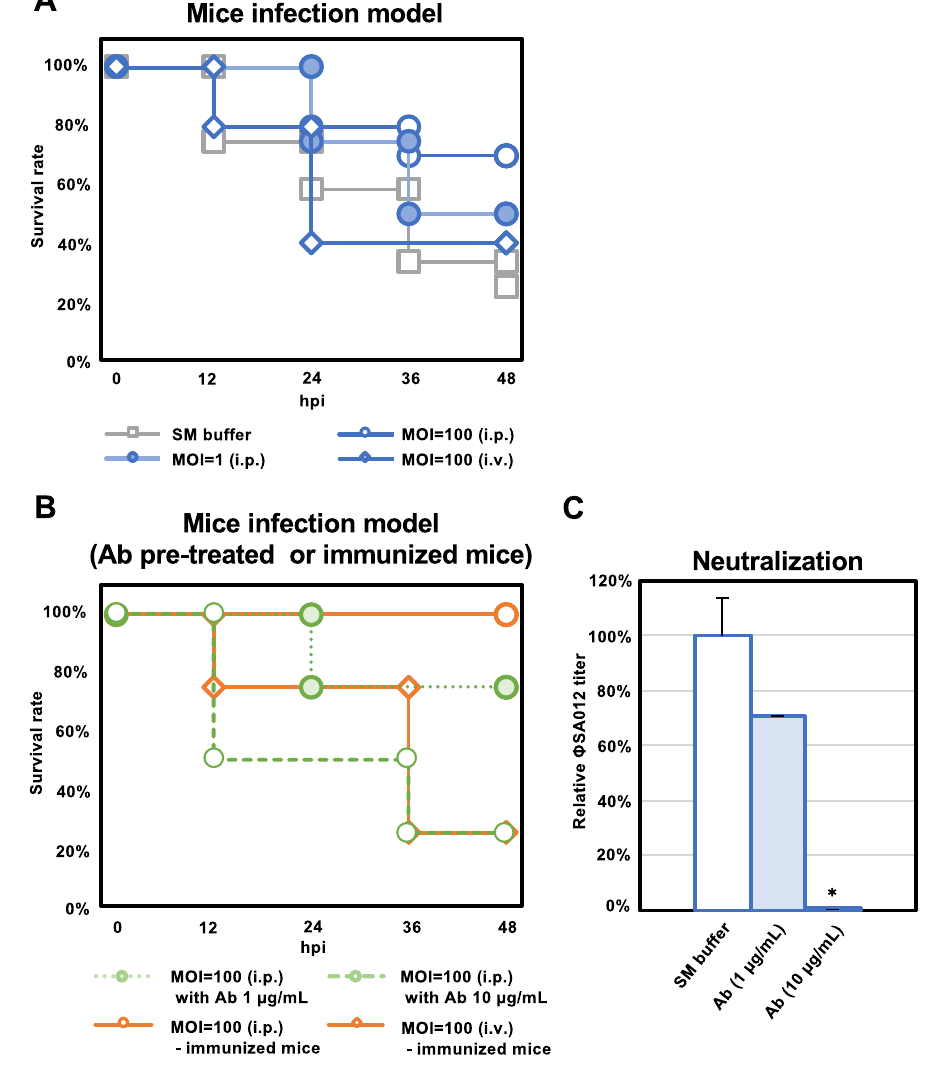
Figure 6. Therapeutic effect of ΦSA012 in a mouse infection model. ( A ) Survival rates of mice inoculated with SA003 through i.p. injections without ΦSA012 treatment (i.p. or i.v.). ΦSA012 was inoculated to mice i.p. or i.v. (n = 12 in the control group, n = 10 at MOI of 100 in the i.p. group, n = 10 at MOI of 100 in the i.v. group, n = 4 at MOI of 1 in the i.p. group). In every experiment, ΦSA012 or SM buffer was injected into mice 15 min after SA003 inoculation. ( B ) Survival rates of mice inoculated with SA003 through i.p. injection with anti-phage antibody (1 µg/mL or 10 µg/mL)-pretreated ΦSA012 treatment and ΦSA012 treatment in immunized mice (n = 4 in each group). ΦSA012 was injected into the mice 15 min after SA003 inoculation. ( C ) Neutralization activity of purified anti-phage IgG against ΦSA012 in vitro (equivalent to MOI of 100 in the mouse infection model). Titers of ΦSA012 are indicated as fold changes against the control and presented as means ± SD (n = 3). Significance against the control was analyzed by Tukey’s test based on one-way ANOVA: * p < 0.05, ** p <